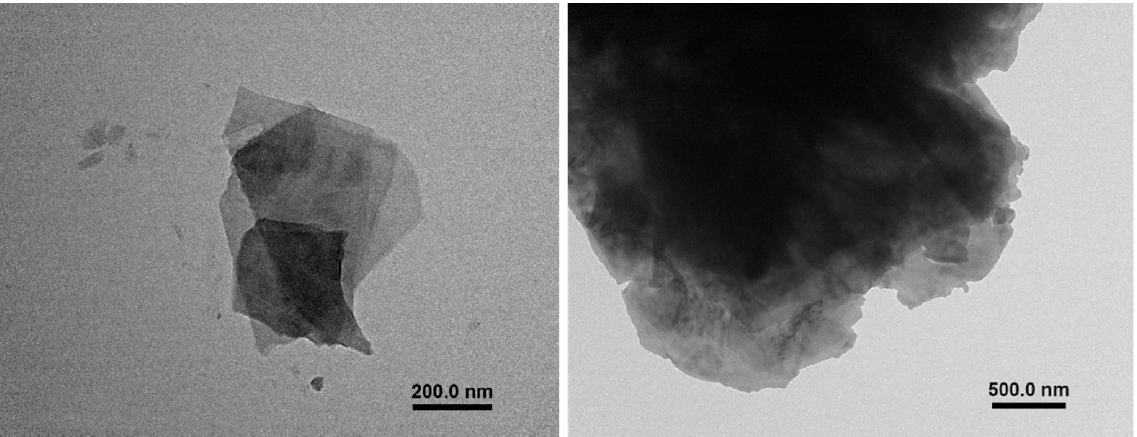
Figure 1 . TEM images of HRCM powder after ultrasonication in isopropanol at two different length scales, showing the presence of superimposed high-ratio flakes with few layers of graphene sheets at the micro-sized length scale.